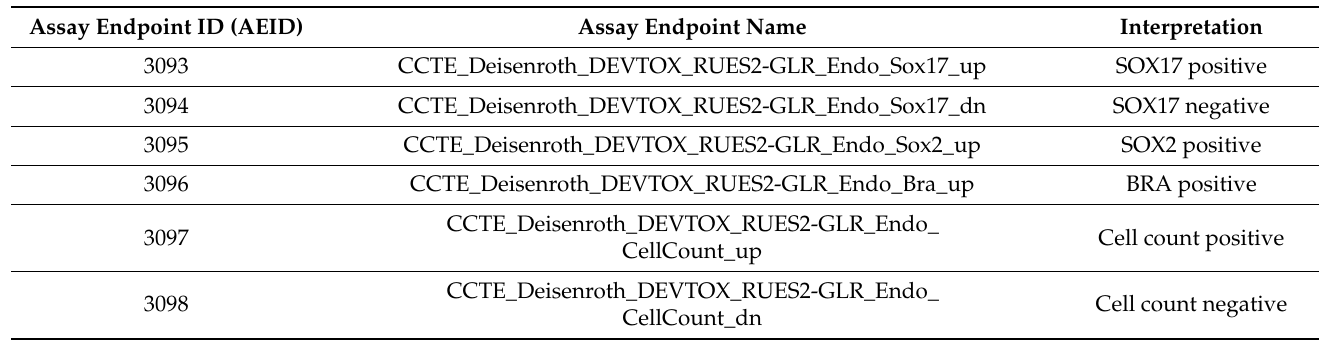
Table 2. DevTox RUES2-GLR Endo Assay Endpoints . Assay endpoint IDs (AEID); Assay endpoint name; interpretation: Positive–increase in biomarker or cell count, negative–reduction in biomarker or cell